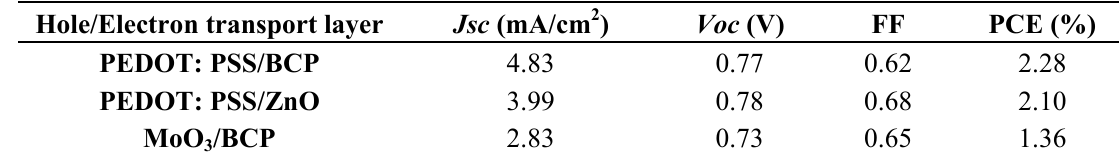
/Electron transport layer/Al using 70